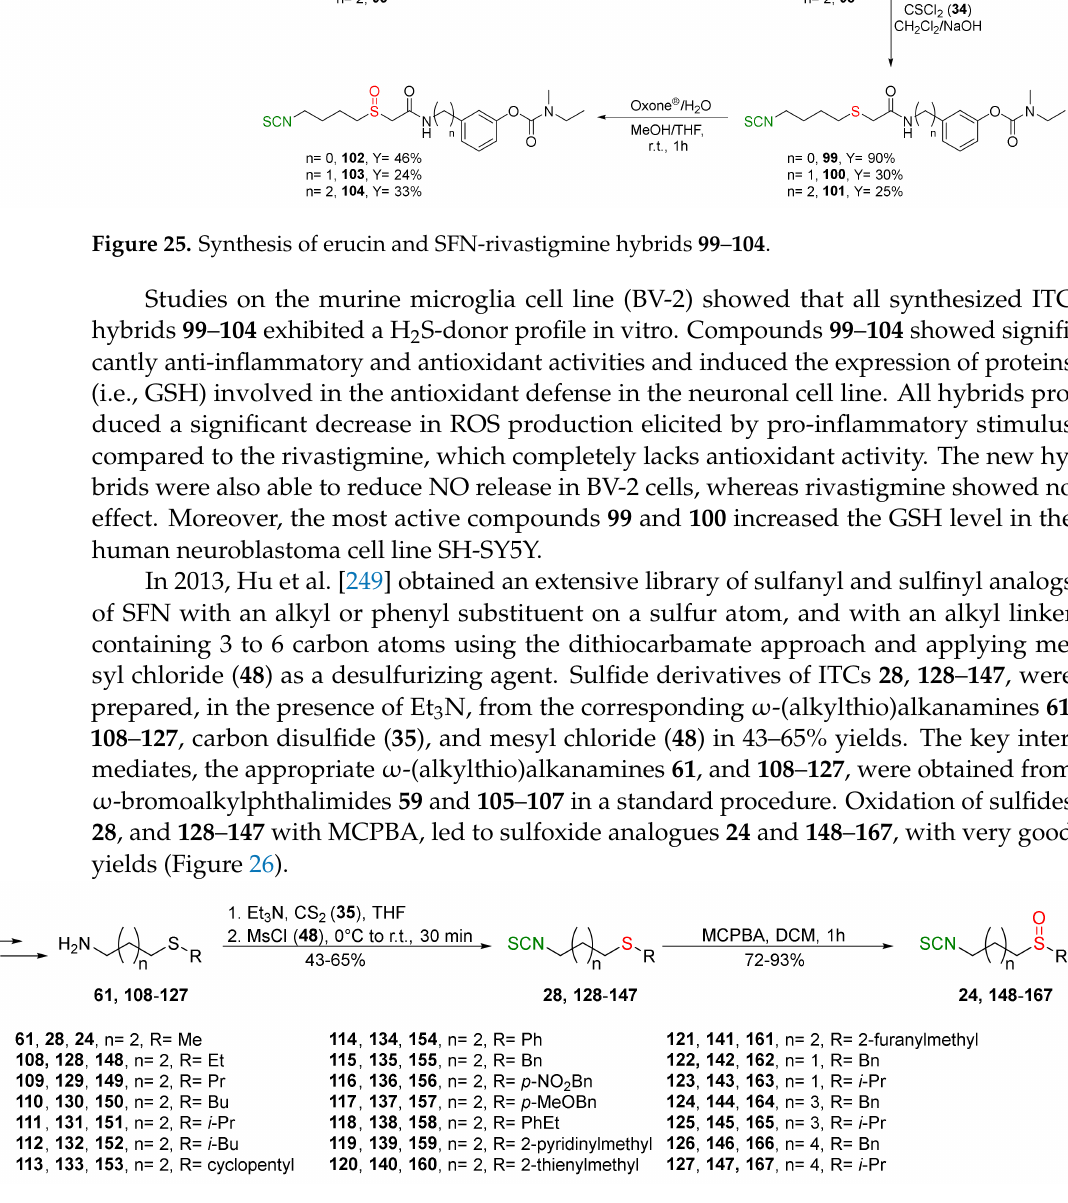
Figure 26. Synthesis of SFN ( 24 ) and its derivatives 148 – 167